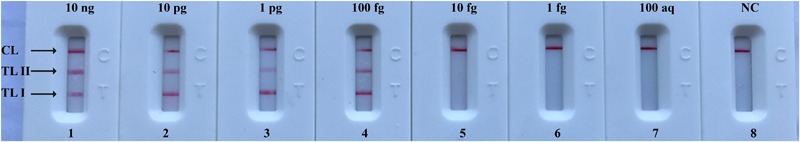
Visual detection of multiplex targets in a m-MCDA reaction. Two sets of MCDA primers targeting nuc and mecA genes were simultaneously added to a reaction vessel and the LoD of m-MCDA for simultaneously detecting S. aureus and identifying MRSA was analyzed using LFB. Biosensors 1, 2, 3, 4, 5, 6, 7, and 8 represent DNA levels of 10 ng (S. aureus ATCC 43300 templates), 10 pg (S. aureus ATCC 43300 templates), 1 pg (S. aureus ATCC 43300 templates), 100 fg (S. aureus ATCC 43300 templates), 10 fg (S. aureus ATCC 43300 templates), 1 fg (S. aureus ATCC 43300 templates), 100 ag (S. aureus ATCC 43300 templates), and negative control (DW). The LoD of m-MCDA assay for nuc and mecA detection was 100 fg per vessel.